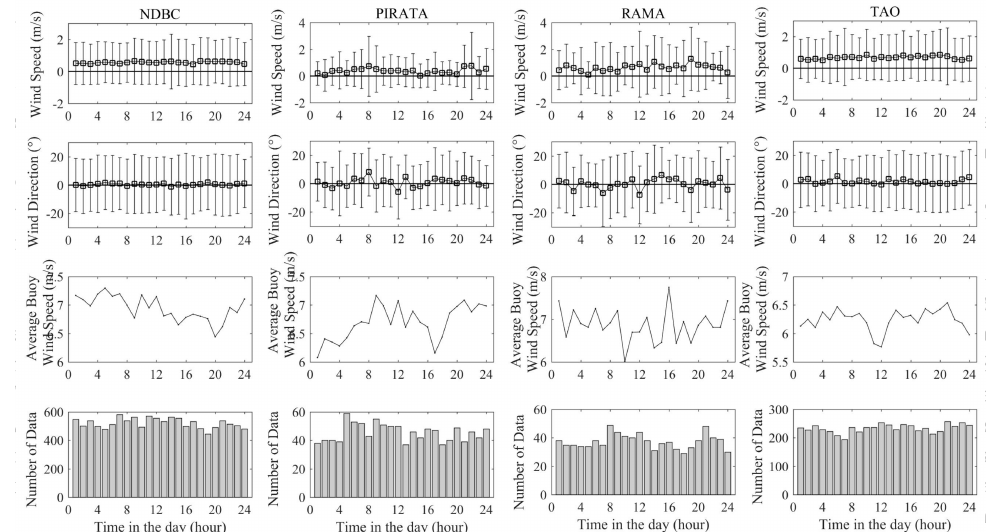
Figure 7. Errors of RapidScat wind vectors at different times of the day for NDBC, PIRATA, RAMA, and TAO buoys.